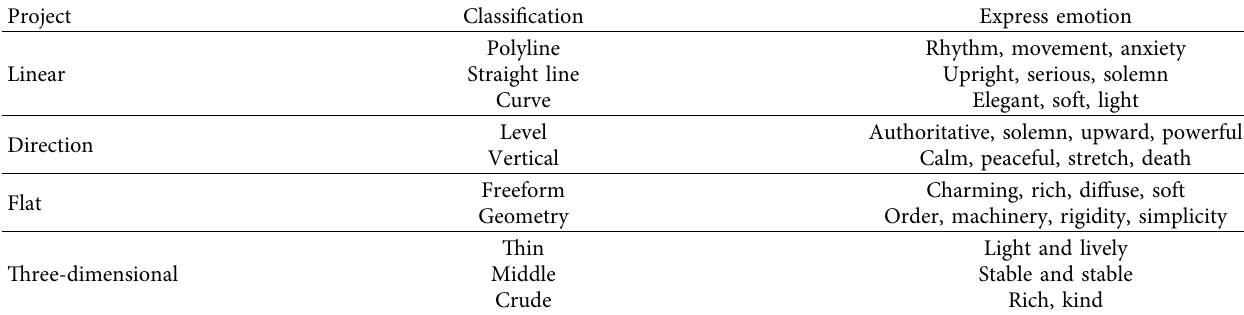
Figure 4: Comparison of glasses with different shapes: (a) cylindrical glass and (b) conical glass. Table 1: Emotional expression of different lines.